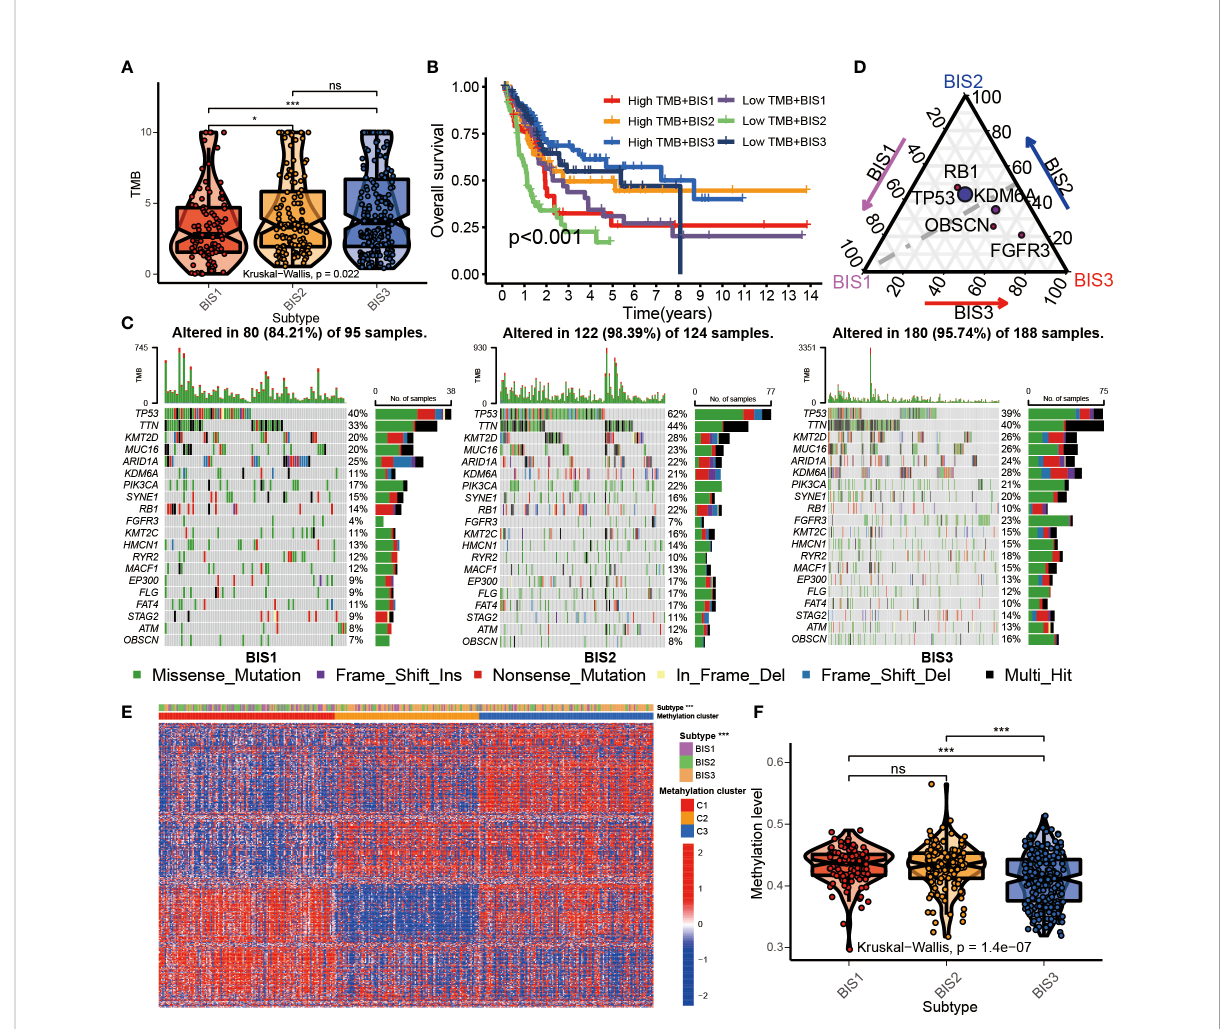
FIGURE 6 Multi-omics characteristics among three subtypes. (A) Boxplot of TMB in three subtypes in TCGA BLCA cohort. (B) Survival analysis for three subtypes and high/low TMB groups in the TCGA BLCA cohorts. (C) The waterfall plot of top 20 mutated genes among three subtypes in the TCGA BLCA cohorts. (D) Triangle plot of differential gene mutation among three subtypes in the TCGA BLCA cohorts. (Fisher ’ s test, P< 0.05) (E) Heatmap of top 500 variance genes methylation level in three subtypes. (F) The average methylation level of immune-related genes in three subtypes in TCGA BLCA cohorts. *P < 0.05, ***P < 0.001; ns, no signi fi